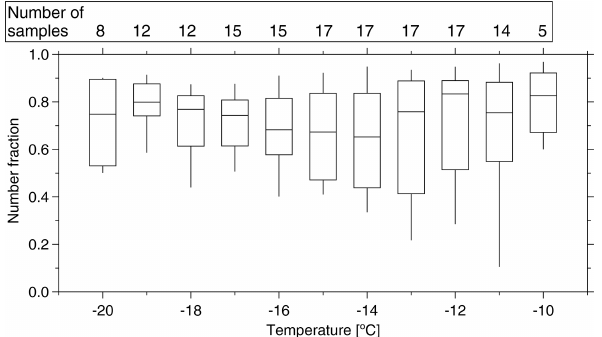
Figure 4. Boxplot of number fraction of INPs in the size range of > 1µm as a function of temperature. The boxes represent the interquartile range. Whiskers represent 10th and 90th percentiles. The number of samples indicated at the top of the figure shows how many different samples contributed at the different